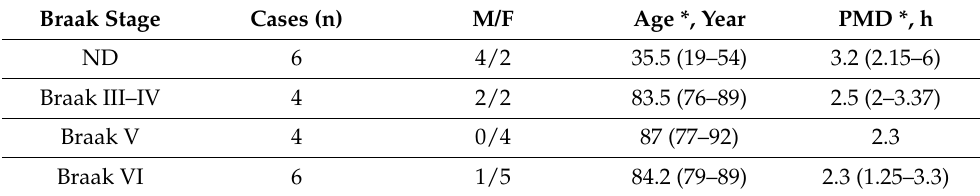
Table 1. Demographic and neuropathological characteristics of the subjects included in this study. Braak Stage Cases